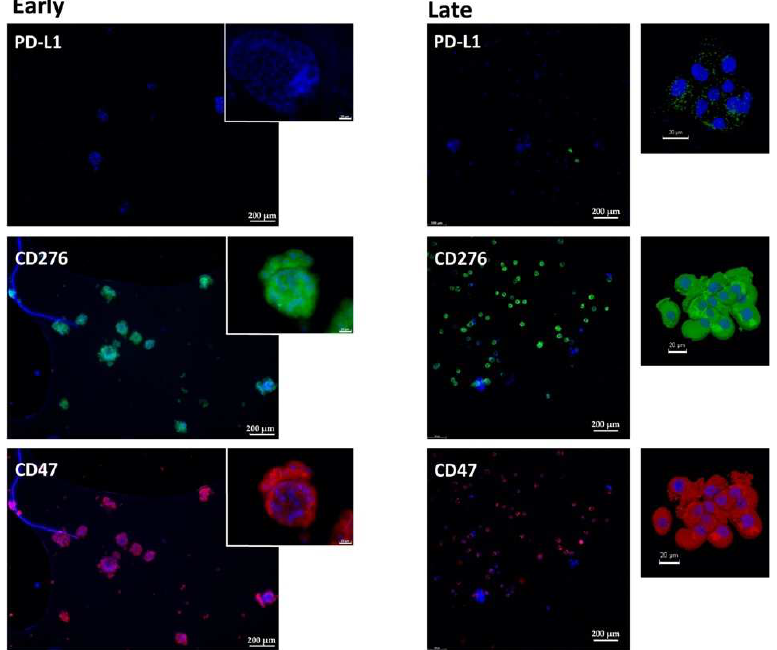
Figure 3. Expression of immune checkpoint antigens on BCO#147 organoids. Organoids of BCO#147, a population with limited in vitro growth capacity, were fixed and directly stained in early passage ( left panel ) or in later passage ( right panel ) cultures with antibodies reactive with PD-L1, CD276, and CD47 as indicated. For each staining, an overview with several organoids and a detailed picture of individual organoids are presented. Size bars indicate 200 μm and 20 μm, respec- tively.